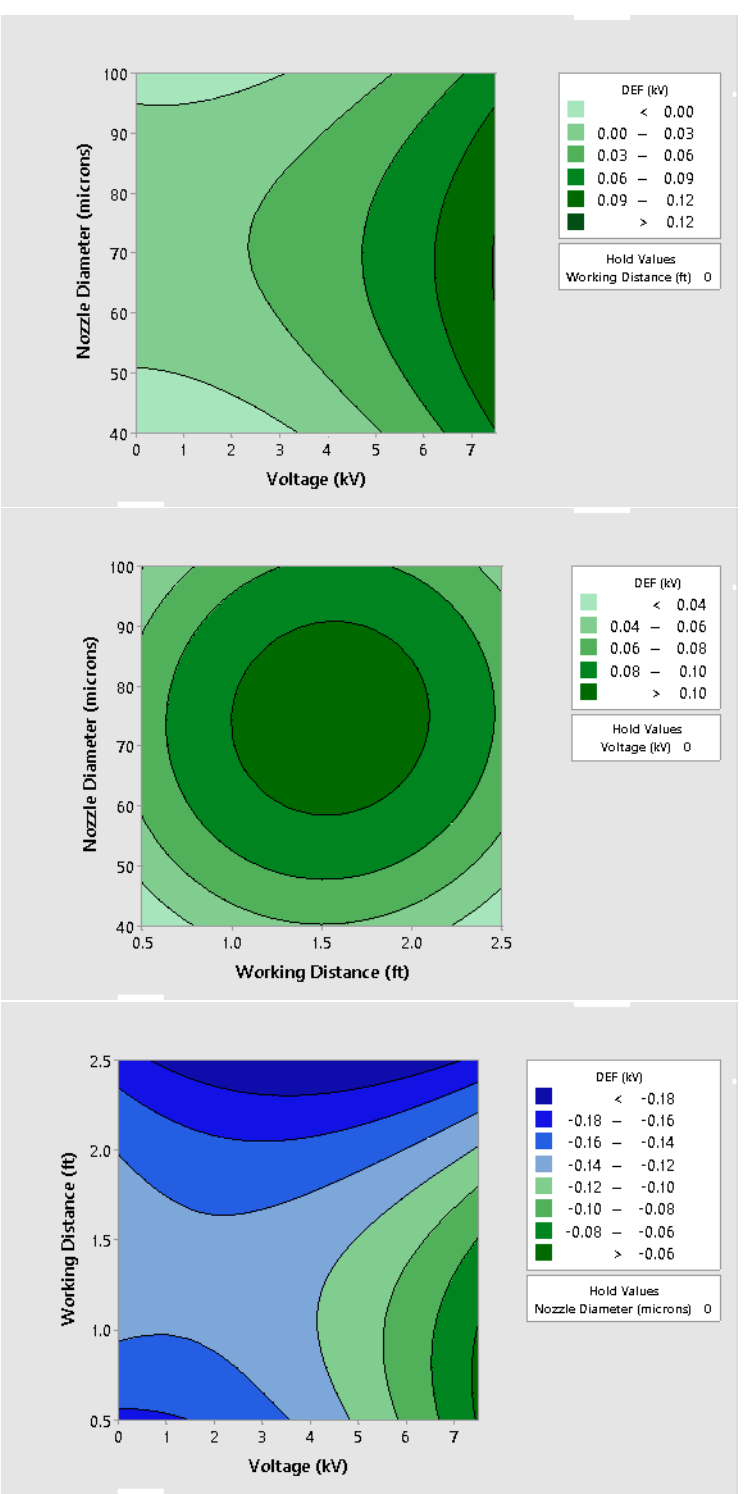
Figure A8. Wood: Quantitative representation of average differential electric field vs. working distance (feet), nozzle sprayer size ( µ m), and charge voltage